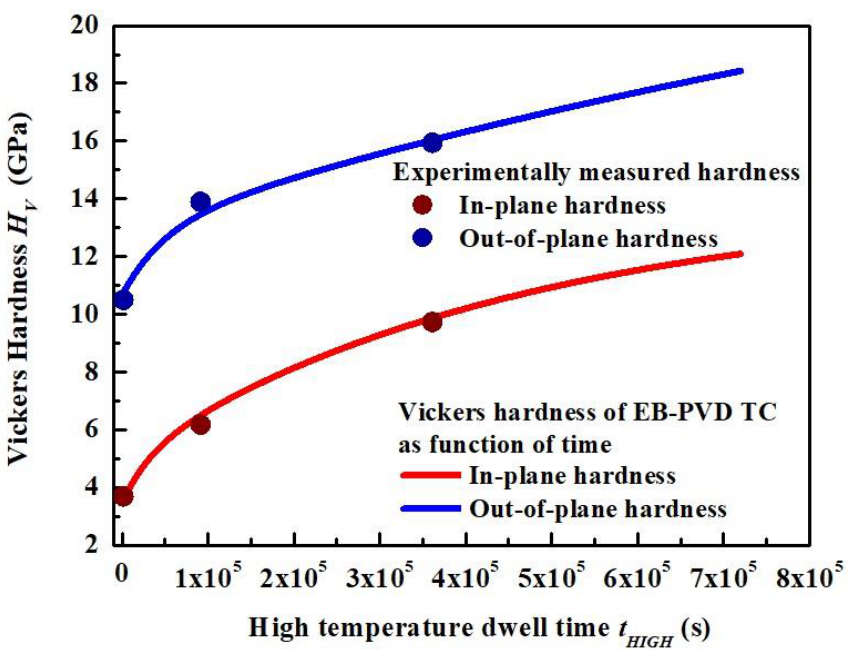
Figure 8. The variation of Vickers hardness during high-temperature dwell period at 1400 °C due to sintering together with experimental data in [40]. Table 2. Fitting parameters used in calculating Vickers